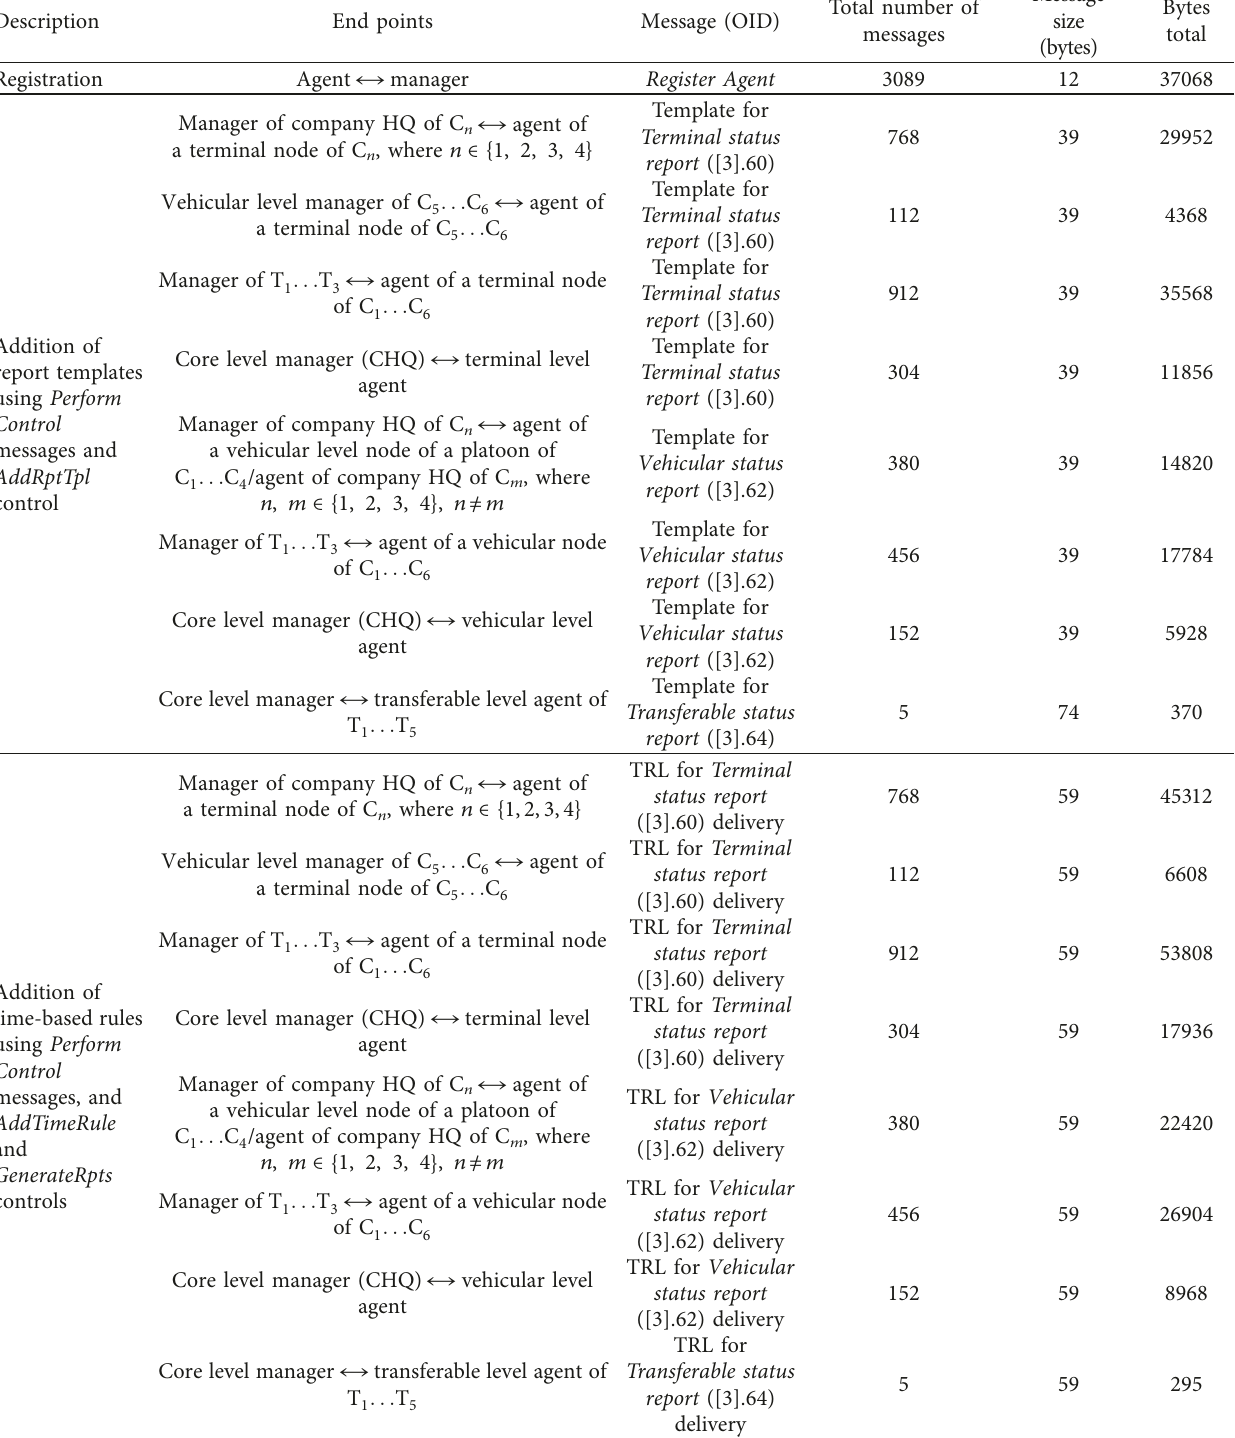
Table 6: DTN-level management messaging of the Anglova scenario when the management service is implemented in a nonhierarchical